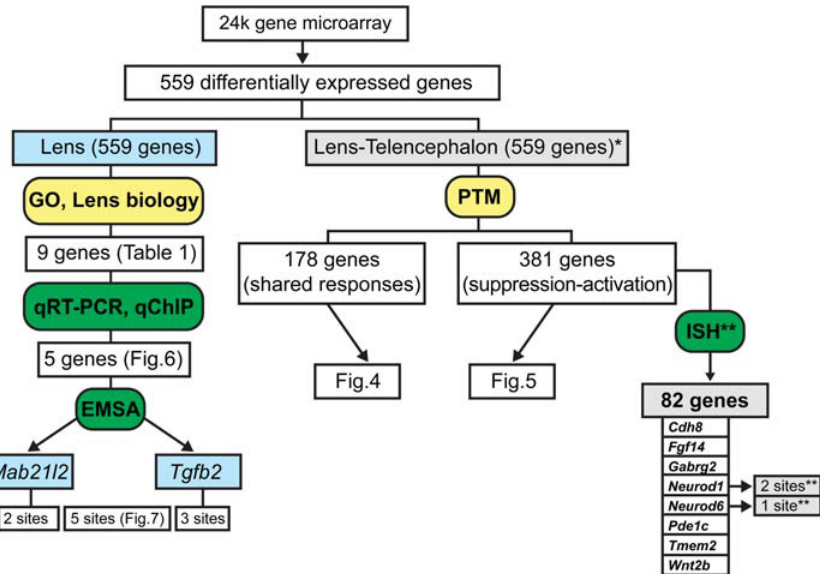
Figure 8. A schematic diagram of computational, analytic and confirmatory strategies. The predicted Pax6-targets were validated by qRT- PCR, qChIP and EMSAs. The left arm of the diagram illustrates a strategy focusing on genes with established roles in the lens. The right arm shows a parallel strategy based on comparative expression profiling in lens and embryonic telencephalon. (*) represent data from [17], (**) represent data from [18]. In situ hybridization data, ISH; Pavlidis Template Matching, PTM; shared responses, S; suppression-activation,